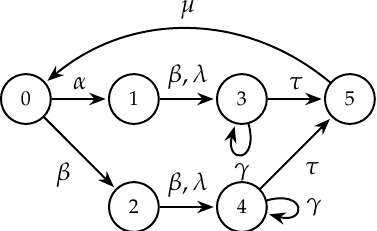
Figure 5. The skeleton of a supervisor for G (cid:48) ( q 1 ) and G (cid:48) ( q 2 )